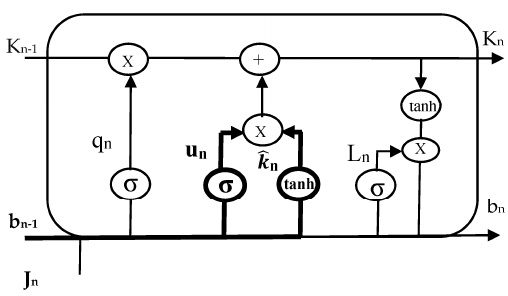
Figure 4. Input gate of LSTM cell.